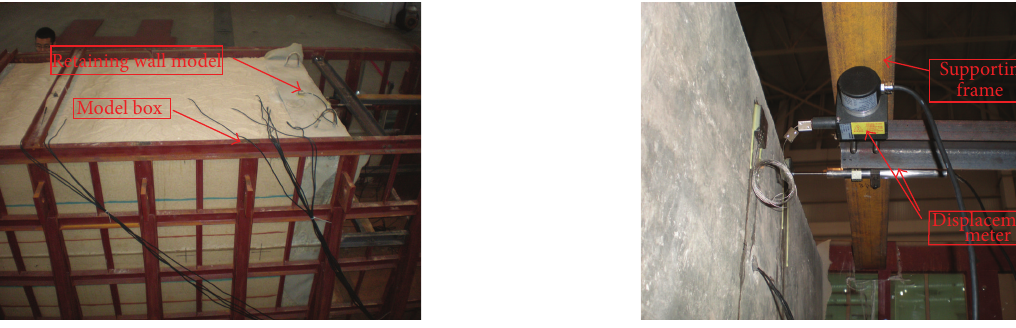
Figure 3: Test model panorama.